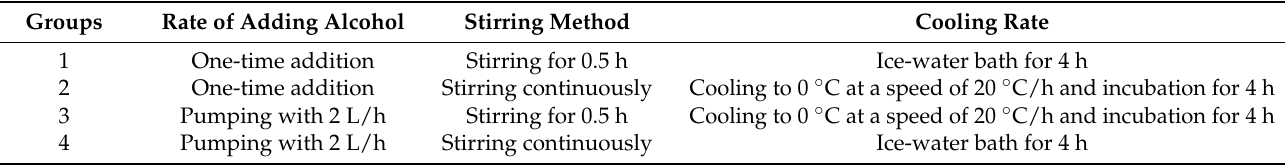
Table 8. Screening of alcohol precipitation